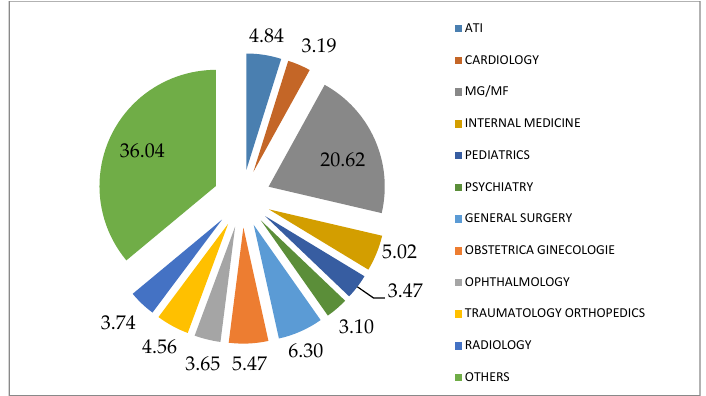
Figure 5. Current Professional Certificates according to specialization, 2017.